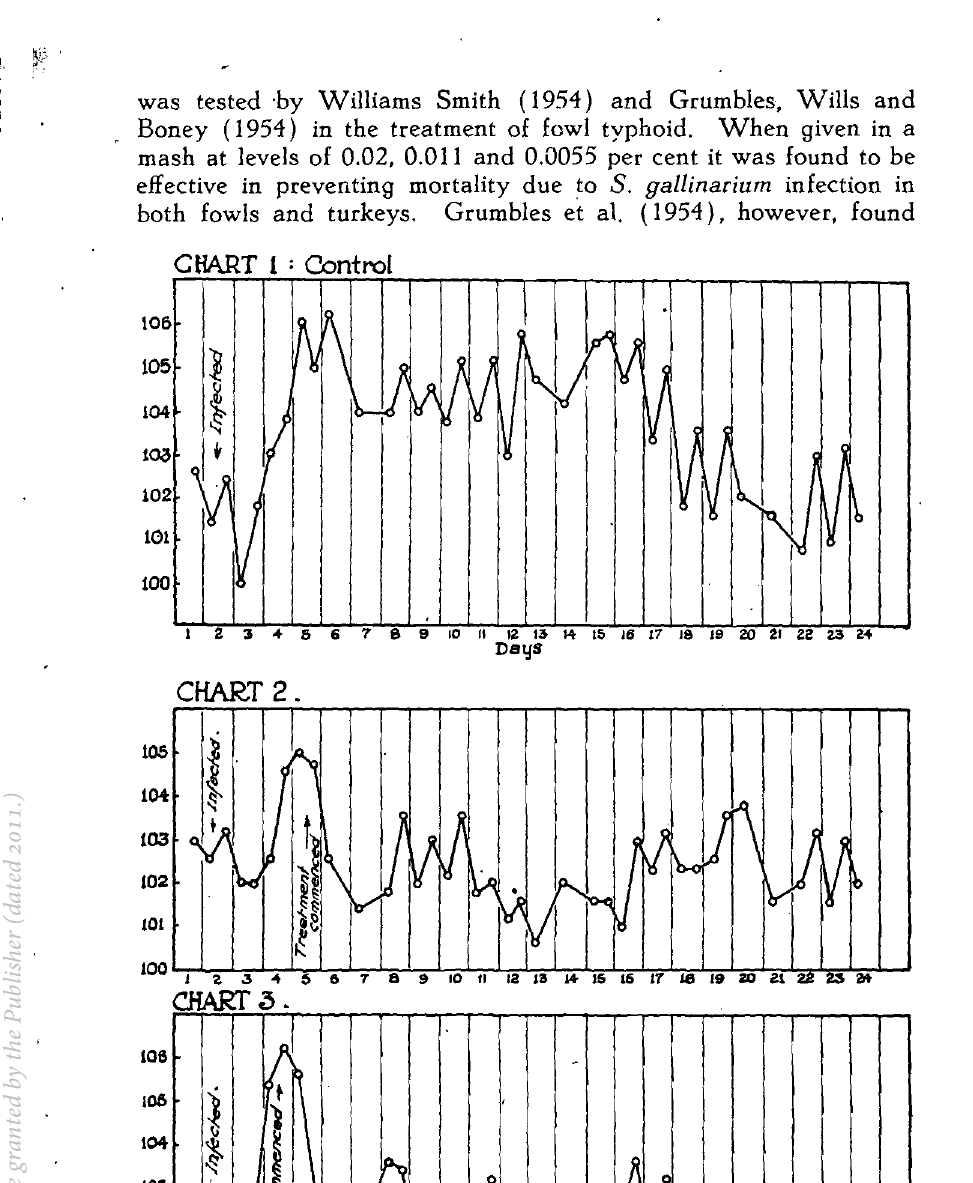
Chart I. The temperature chart of the control group. Chart II. .The temperature chart of the chloromycetin group. Chart III. The temperature chart of the furazolidone